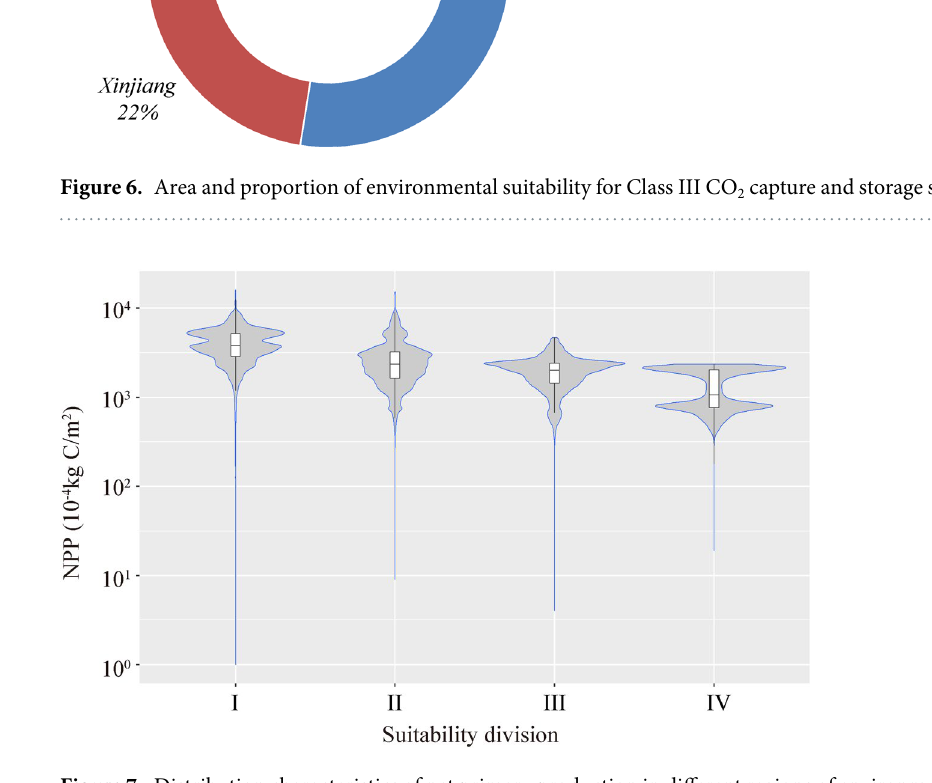
Figure 7. Distribution characteristics of net primary production in different regions of environmental suitability classes related to CO 2 capture and storage. Note: The violin plots show the probability density of the data at different values on each side. The bottom, the band inside and top of the box plot inside the violin plot indicate the first quartile, the median and fourth quartiles of the